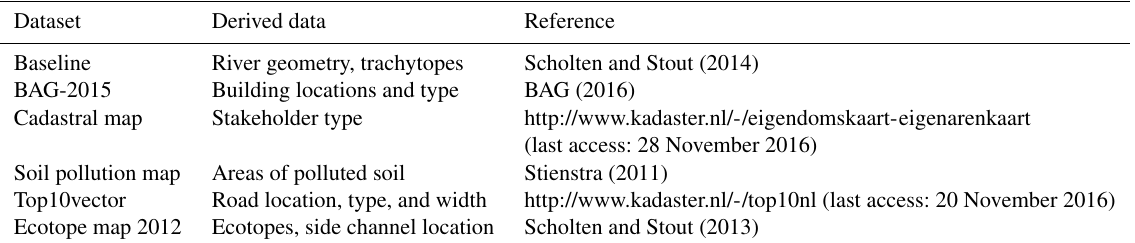
Table 2. Overview of input datasets used for intervention planning and evaluation.